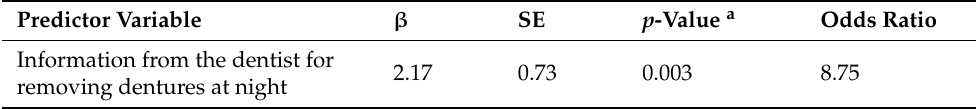
Table 11. The association between denture removal at night and information from the dentist. Predictor Variable β SE p -Value a Odds Ratio Information from the dentist